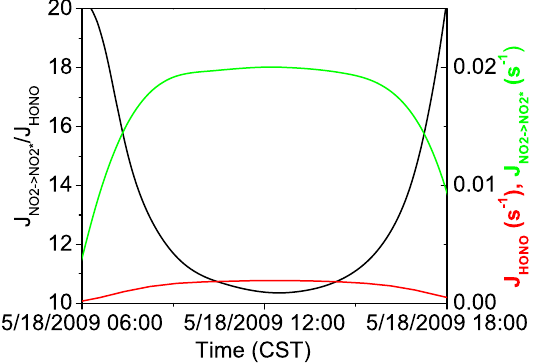
Fig. 7. Measured diurnal variation of the photolysis frequency of HONO, the photolysis frequency of NO 2 to photoexcited NO 2 , and their ratio on a clear and sunny day in